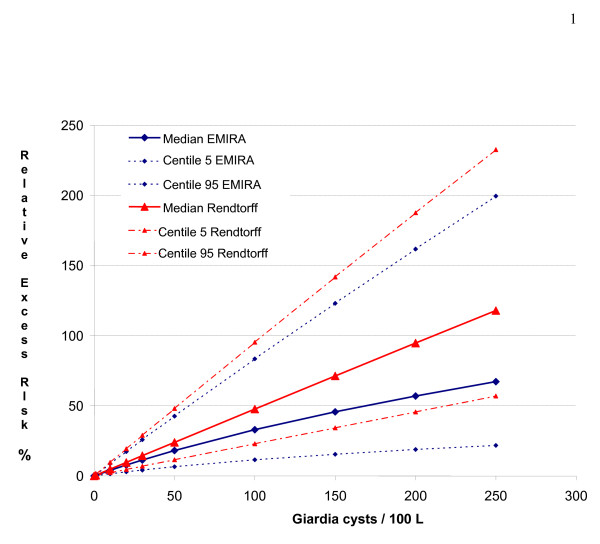
Relative excess risk (in %, and 95% confidence intervals) attributable to Giardia counts in tap water : comparison of results derived from the E.MI.R.A observations (in blue) and from the experimental exponential model (in red) after application of a 20 % abatement factor